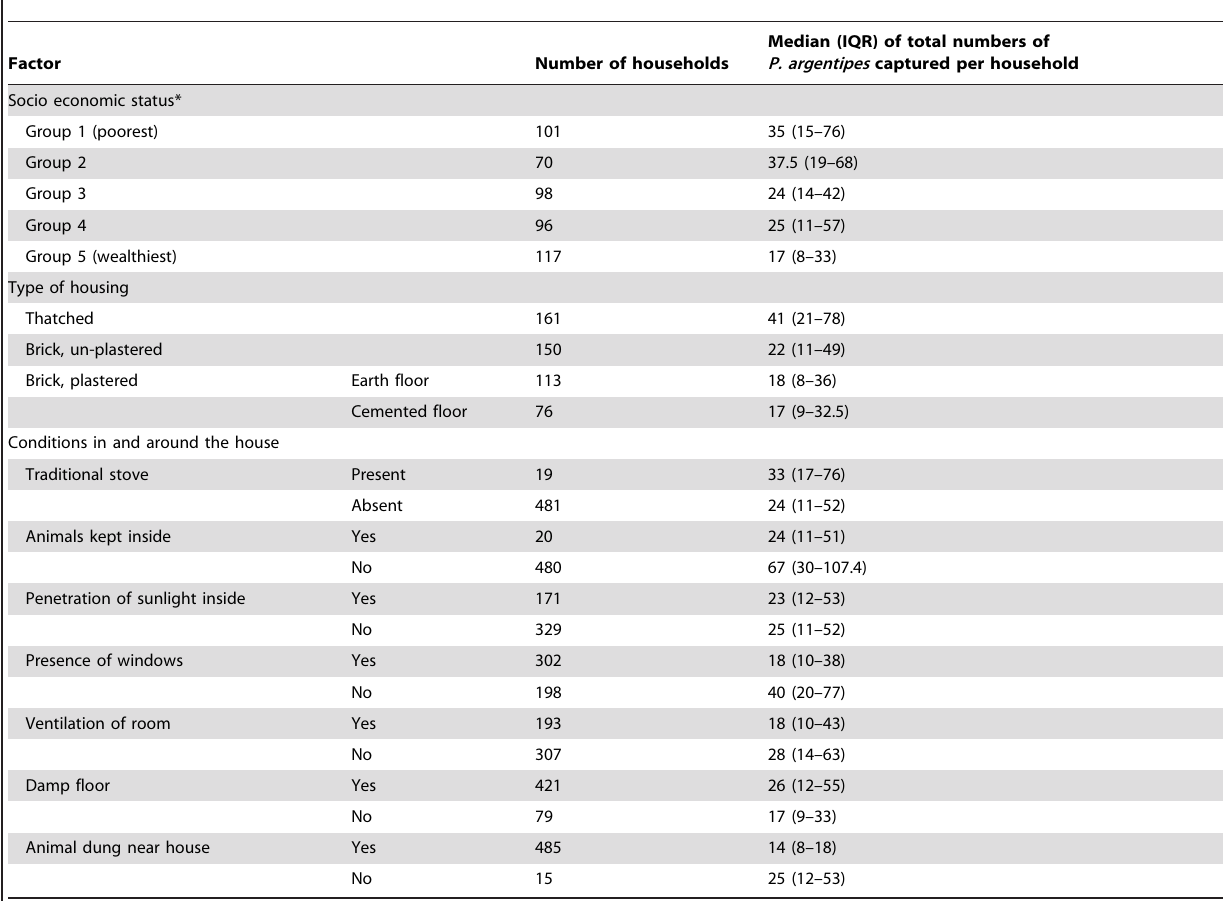
Table 2. Factors associated with Phlebotomus argentipes indoor